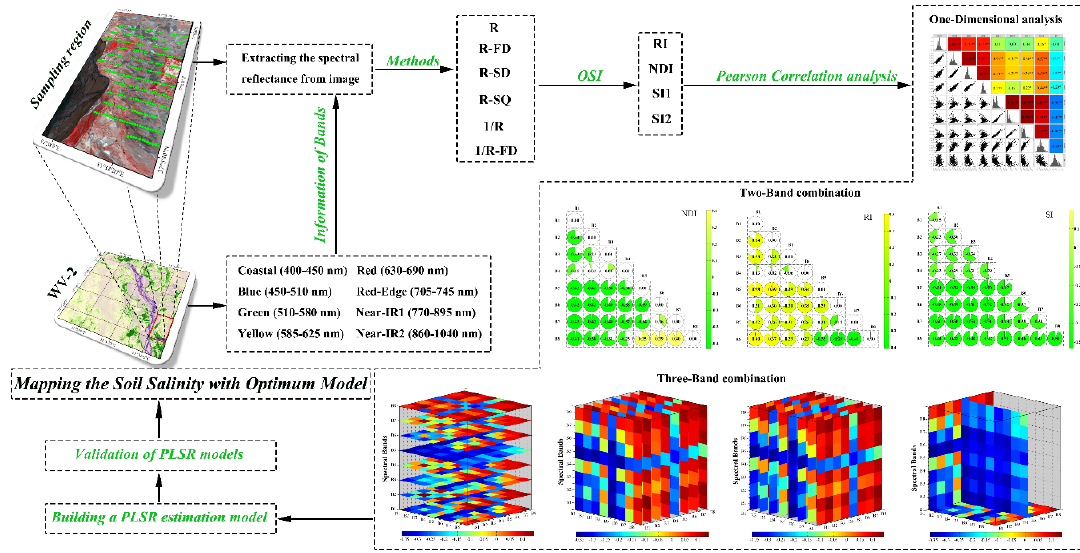
Figure 2. Overall workflow of the study.